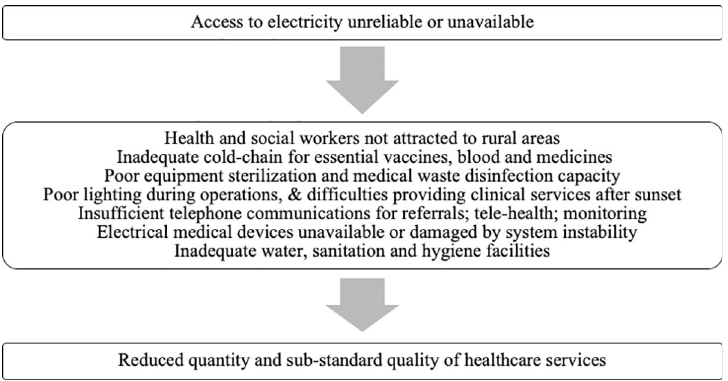
Fig 1. Potential causes leading to deficiencies in the health system, exacerbated by poor energy access (adapted from [1]).